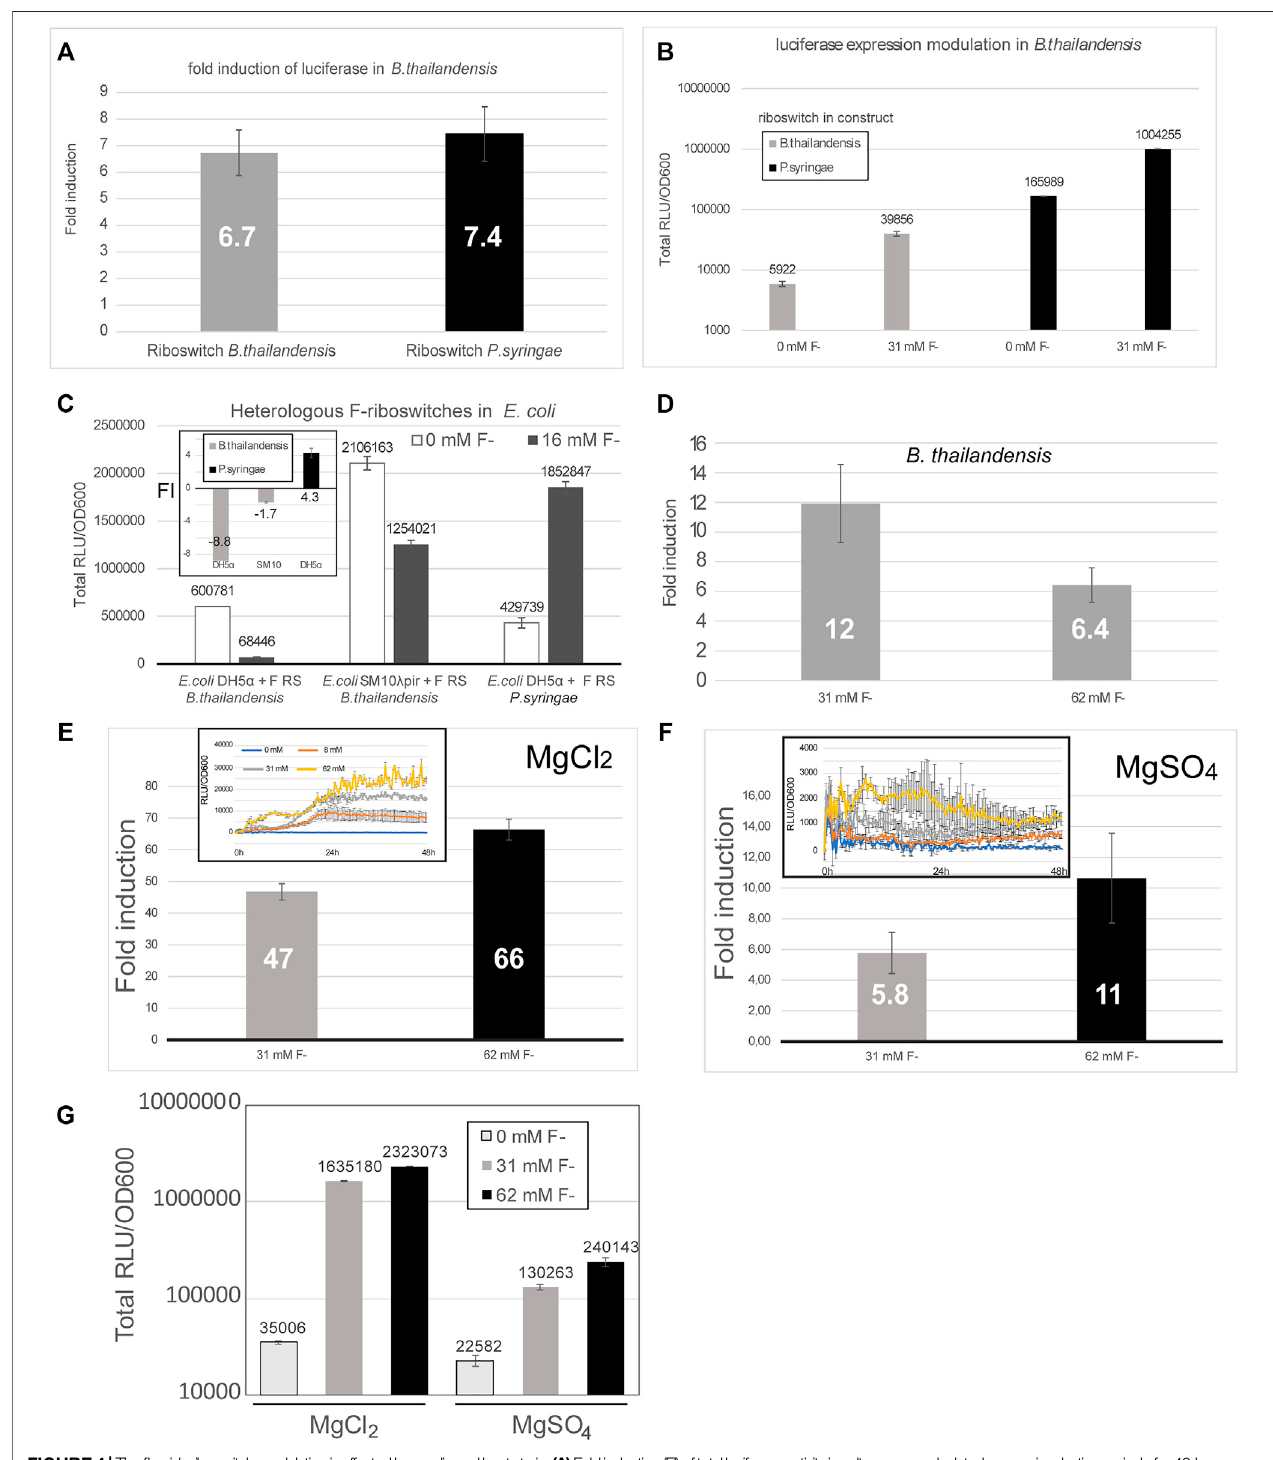
FIGURE4| The fl uorideriboswitchmodulationisaffectedbymediaandhoststrain. (A) Foldinduction(FI)oftotalluciferaseactivityincultureswascalculatedoveranincubationperiodof ∼ 40h ( B. thailandensis transformed with the B. thailandensis E264 fl uoride riboswitch construct — pVK-f2- lux ) and ∼ 55h ( B. thailandensis E264, transformed with P. syringae fl uoride riboswitch construct — pVK-f- lux ).Bothplasmidsarereplicativein E.coli strainsandintegrativein B.thailandensis E264.Bothpre-culturemedia(LB)andexpressionmedia(0.5XM9-MM)weresupplemented withappropriateantibioticsdependingonthespecies(seeMethods). (B) Thesameresultsarerepresentedwiththedirectluminescence(sum)data. (C) Fluorideinductionconcentrationswere 16mMfor E.coli DH5 α and E.coli SM10 λ pirtransformantsand31mMfor B.thailandensis E264.Concentrationswerechosenaccordingtothemaximuminductioneffect.TheFIvaluesforeach sample represent the means and standard deviations of triplicates on the same microplate. (D) Fold induction (FI) of B. thailandensis E264 transformed with the B. thailandensis E264 fl uoride riboswitch for 31 mM and 62 mM of fl uoride. (E – G) Different culturing conditions (MgCl 2 vs MgSO 4 ) were also evaluated. A much stronger induction by fl uoride can be noticed with MgCl 2 .